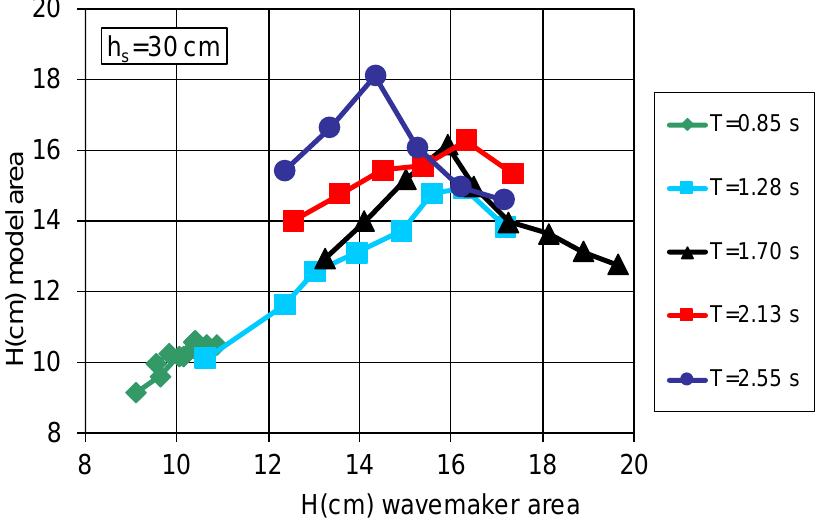
Figure 7. H measured at the model area as a function of H measured at the wave generation zone ( m = 0).